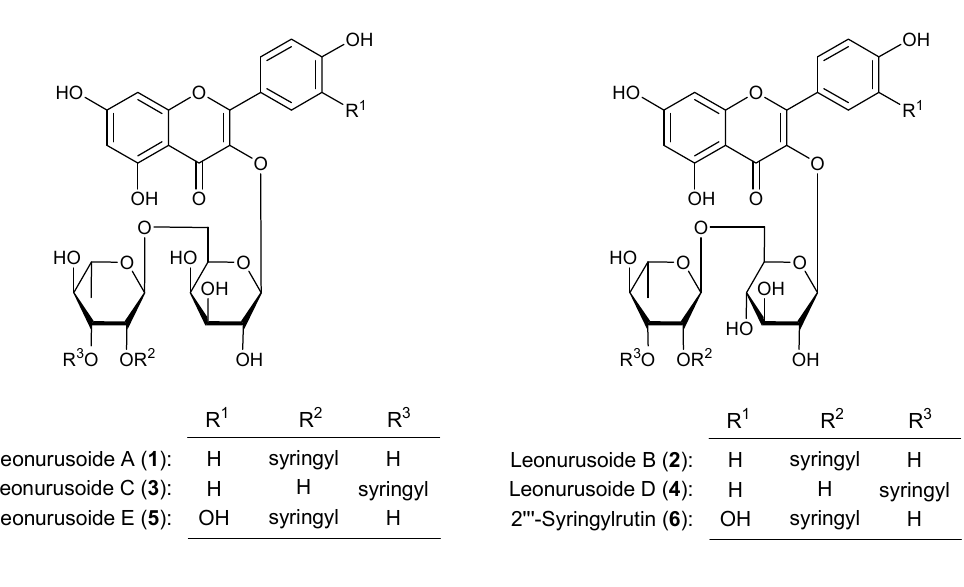
Figure 1. Chemical structures of 1  6